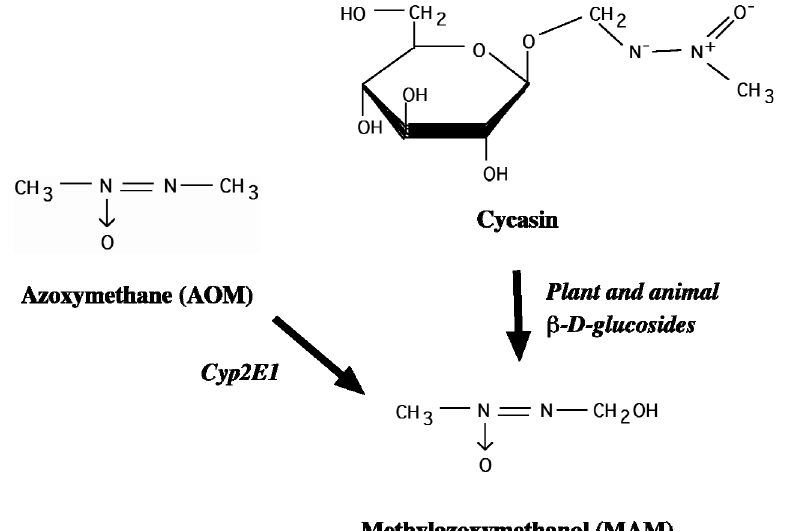
Figure 7. Structure of the cycad genotoxins cycasin (methylazoxymethanol-  -D-glucoside), methylazoxymethanol (MAM) and the related compound azoxymethane (AOM). The azoxyglycoside cycasin is converted to MAM by plant and animal  -glucosidases whereas azoxymethane is converted to MAM by mixed function oxidases ( i.e. , P450